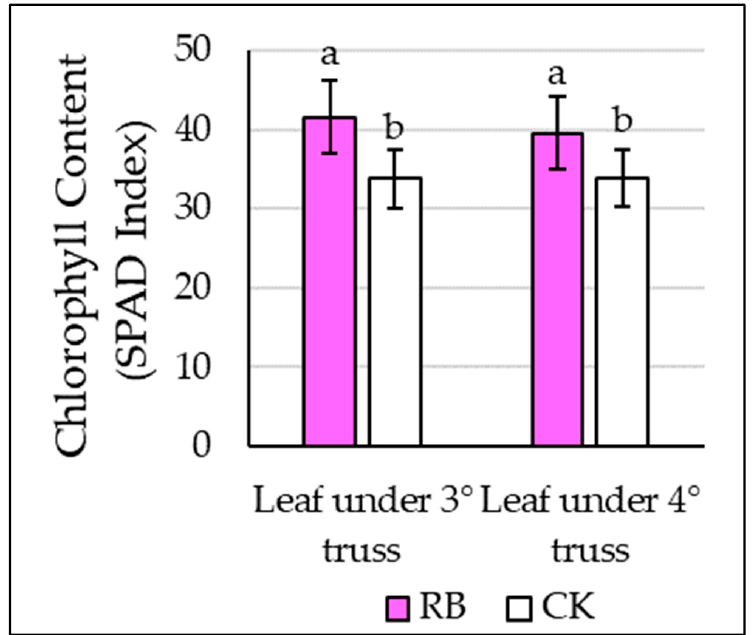
Figure 1. Effects of supplemental red and blue LED light (RB) and natural light only (CK) on leaves’ chlorophyll content (SPAD Index). Different letters indicate significant differences at ANOVA (significant level p ≤ 0.05). Vertical bars represent standard errors. Table 2. Effects of the two separated factors, light (supplemental red and blue LED light, RB, and natural light, CK) and defoliation (early leaf removal, R, and no-removal, NR), on net photosynthesis (A), effective quantum yield efficiency of PSII ( Φ PSII) and photochemical quenching of PSII (qP) . Different letters indicate significant differences at ANOVA (significant level p ≤ 0.05).